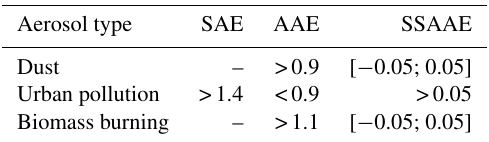
Table 3. Updated Ångström exponent values expected for aerosol types at the CHC